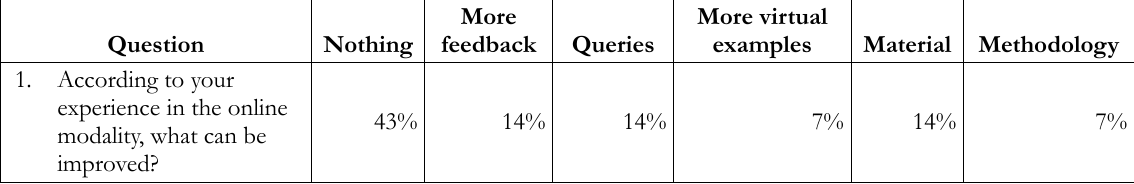
Table 11. Responses to the first open question of the student satisfaction